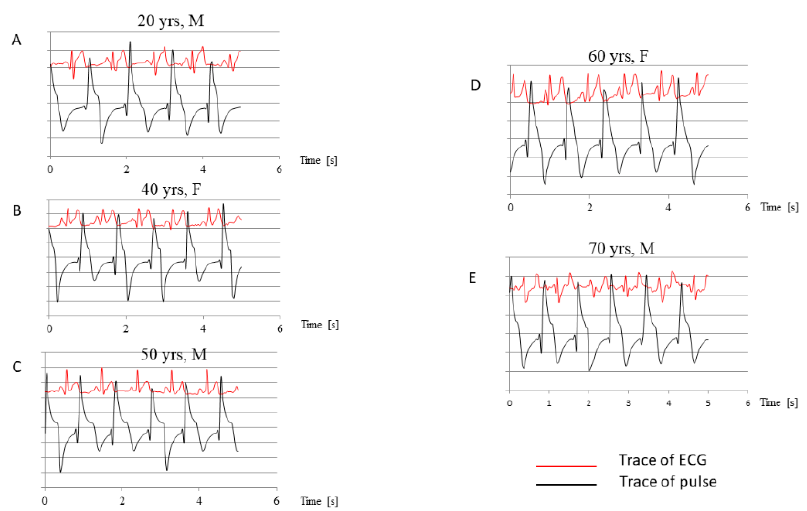
Figure 4. Comparison of simultaneous pulse and ECG trace record. ECG, electrocardiogram; F, female; M, male; yrs, years; ( A – E ) panels show the examples of simultaneous traces of ECG and pulse recorded in different patients.